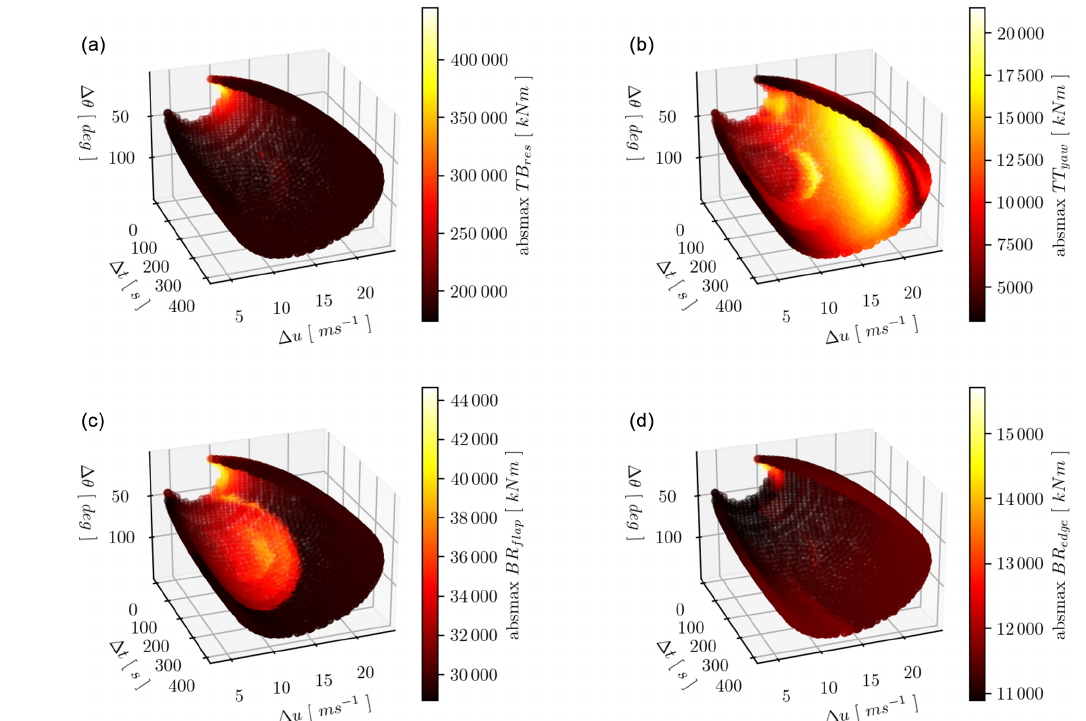
Figure 5. Simulation results with yaw control. The absolute maximum responses are shown with the color scale on the 3D gust variable surface of rise time, amplitude, and direction change. The relevant channel is indicated on the right of the color bar legend: (a) tower-bottom resultant moment, (b) tower-top yawing moment, (c) blade root flap moment, and (d) blade root edge